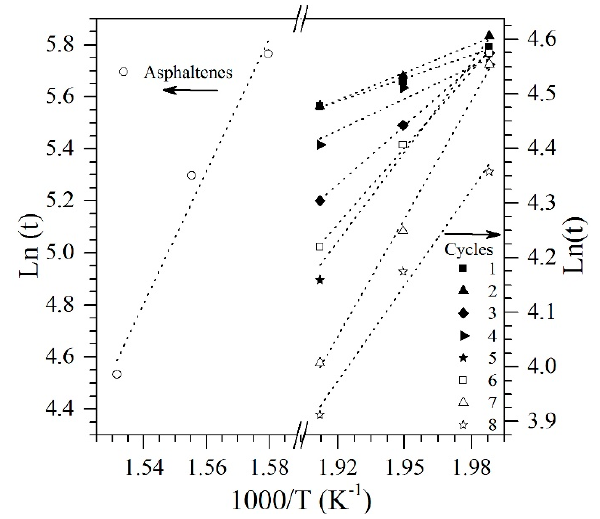
Figure 6. Arrhenius plot for the isothermal model of decomposition-gasification of n -C 7 asphaltenes in the presence and absence of nanoparticles CeNi0.89Pd1.1 through regeneration cycles of adsorption and subsequent catalytic steam gasification.